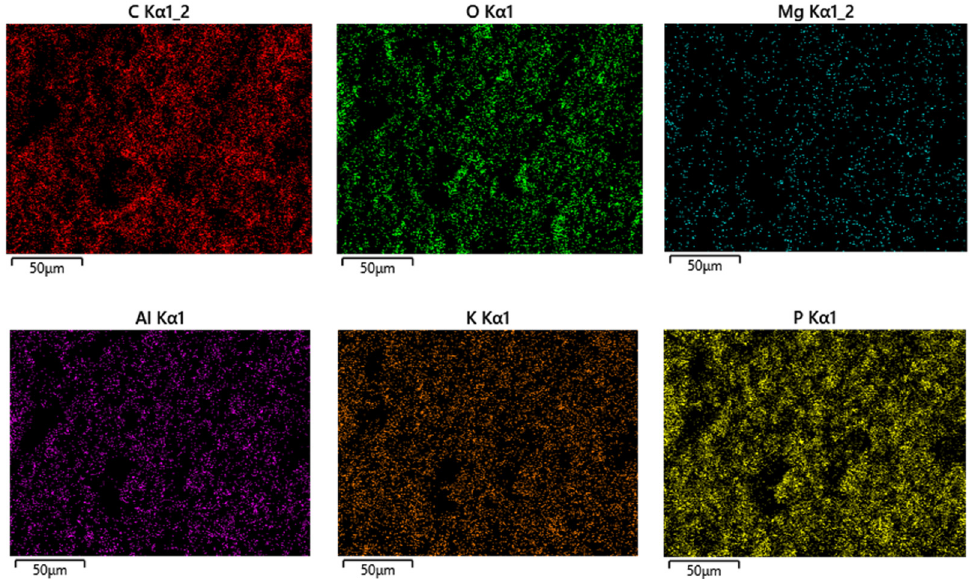
Figure 6. Elemental mapping for the Eb150 + 30%G residue after cone calorimetry tests.